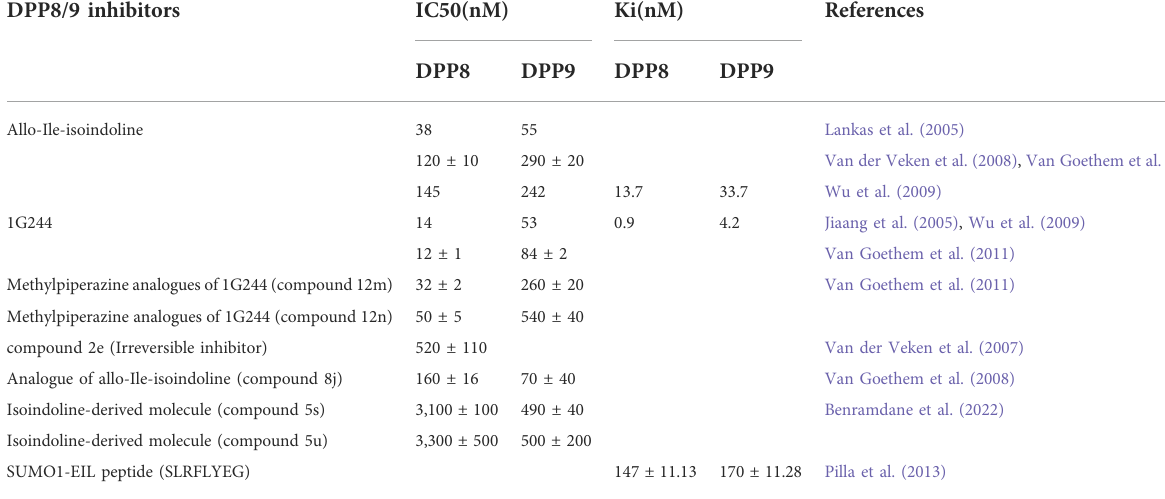
TABLE 2 Potency of selective DPP8/9